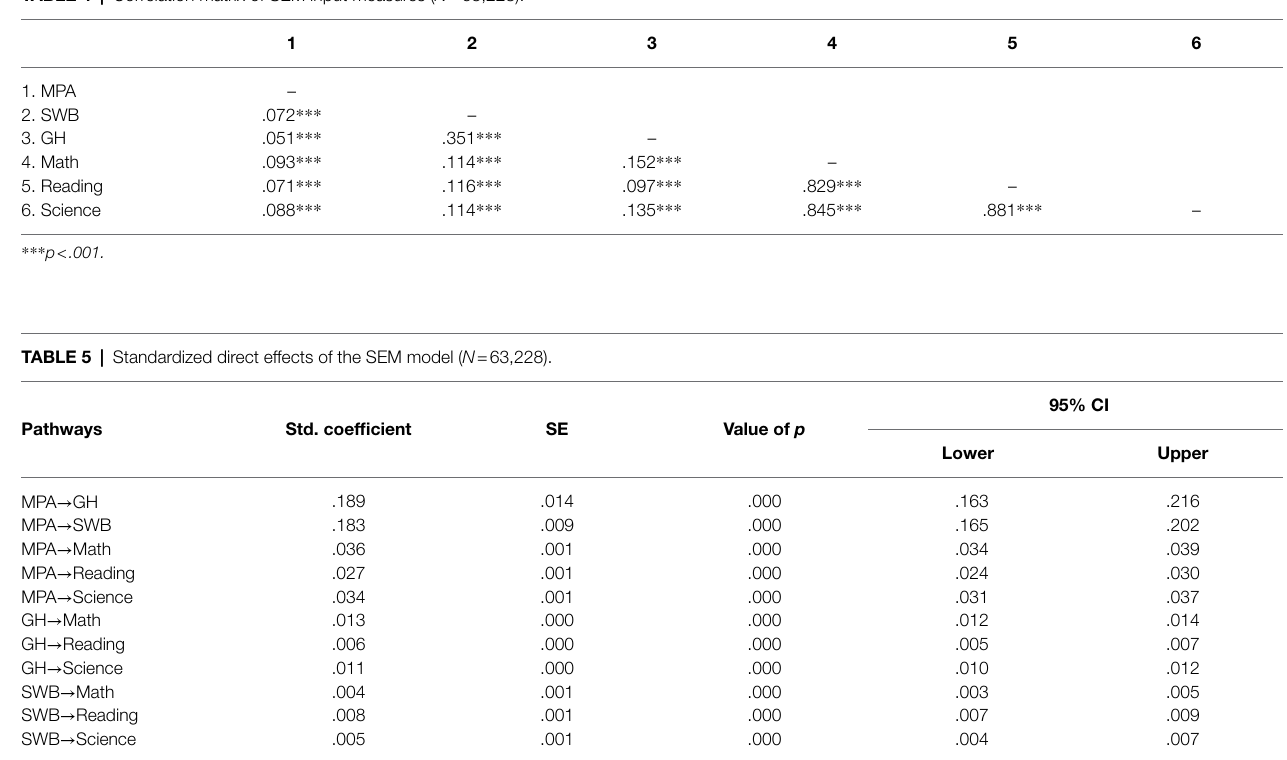
amount of expected learning gains per year among middle- to-high income countries, while Evans and Yuan (2019) estimated learning gains per year between .15 and .21 standard